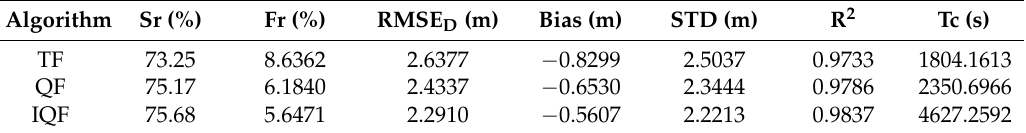
Table 3. Performance assessments of the three mathematical approximation algorithms for waveform